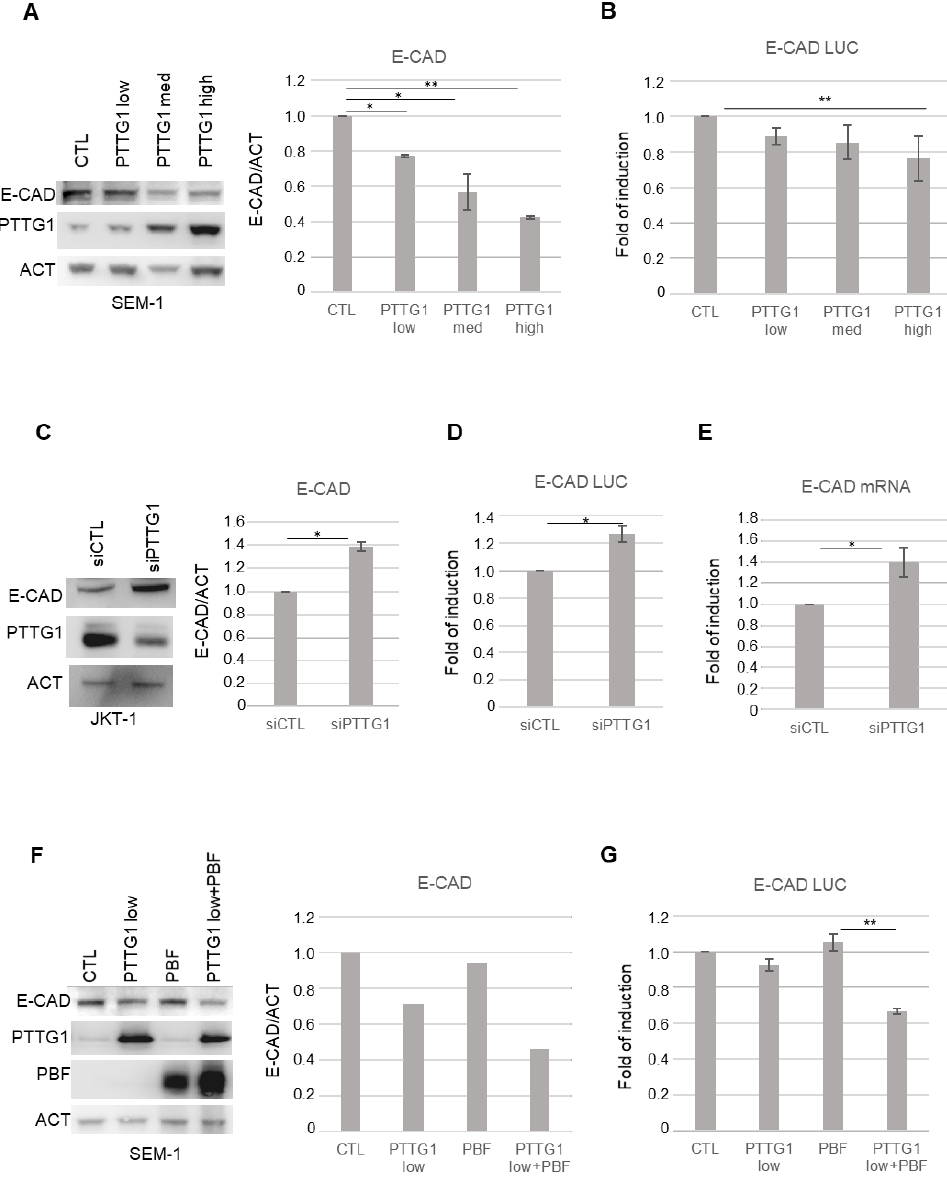
Figure 1. PTTG1 regulation of E-CAD in seminoma cell lines. ( A ) Left panel: representative Western blot analysis (Wb) of the indicated proteins in SEM-1 cell line. “Low”, “Med”, and “High” indicate increasing amount of transfected PTTG1 plasmid. Right panel: Histogram shows the ratio of densi- tometric values of E-CAD to actin (ACT) referred to left panel. Mean ± SD of three independent biological replicates is shown (N = 3; * = p < 0.05, ** = p < 0.01, two-tailed unpaired t -test). ( B ) Histo- gram shows the fold of induction of luciferase activity, normalized to Renilla internal control signal, set arbitrarily to 1 in control transfection (CTL). Mean ± SD of three independent biological replicates is shown (N = 3; ** = p < 0.01, two-tailed unpaired t -test). ( C ) Left panel: representative Western blot analysis (Wb) of the indicated proteins in JKT-1 cell line upon siRNA of PTTG1 (siPTTG1) or control (siCTL). Right panel: Histogram shows the ratio of densitometric values of E-CAD to actin (ACT) referred to left panel. Mean ± SD of three independent biological replicates is shown (N = 3; * = p < 0.05, two-tailed unpaired t -test). ( D ) Histogram shows the fold of induction of luciferase activity, normalized to Renilla signal, set arbitrarily to 1 in control transfection (CTL). Mean ± SD of three independent biological replicates is shown (N = 3; * = p < 0.05, two-tailed unpaired t -test). ( E ) Histo- gram shows the fold of induction of E-CAD mRNA relative to actin upon siRNA of PTTG1 (siPTTG1) and control (siCTL), set arbitrarily to 1 in control transfection (CTL). Mean ± SD of three independent biological replicates is shown (N = 3; * = p < 0.05, two-tailed unpaired t -test). ( F ) Left